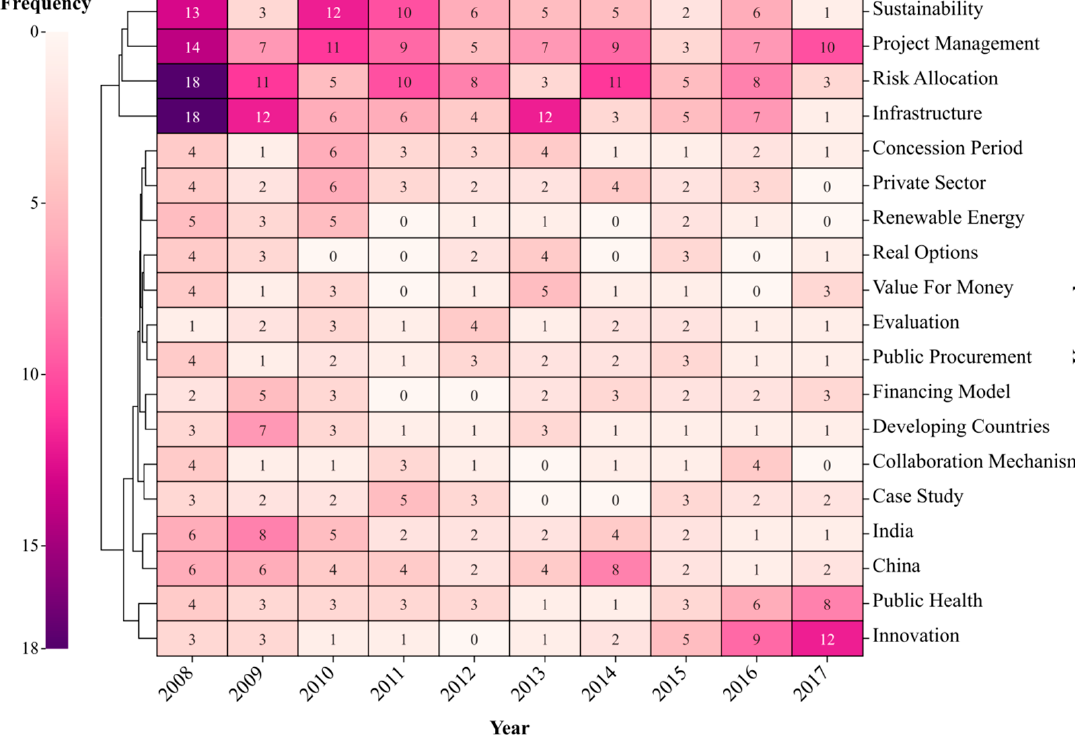
Figure 6. Time Zone Biclustering Analysis in Rapid Development Period.